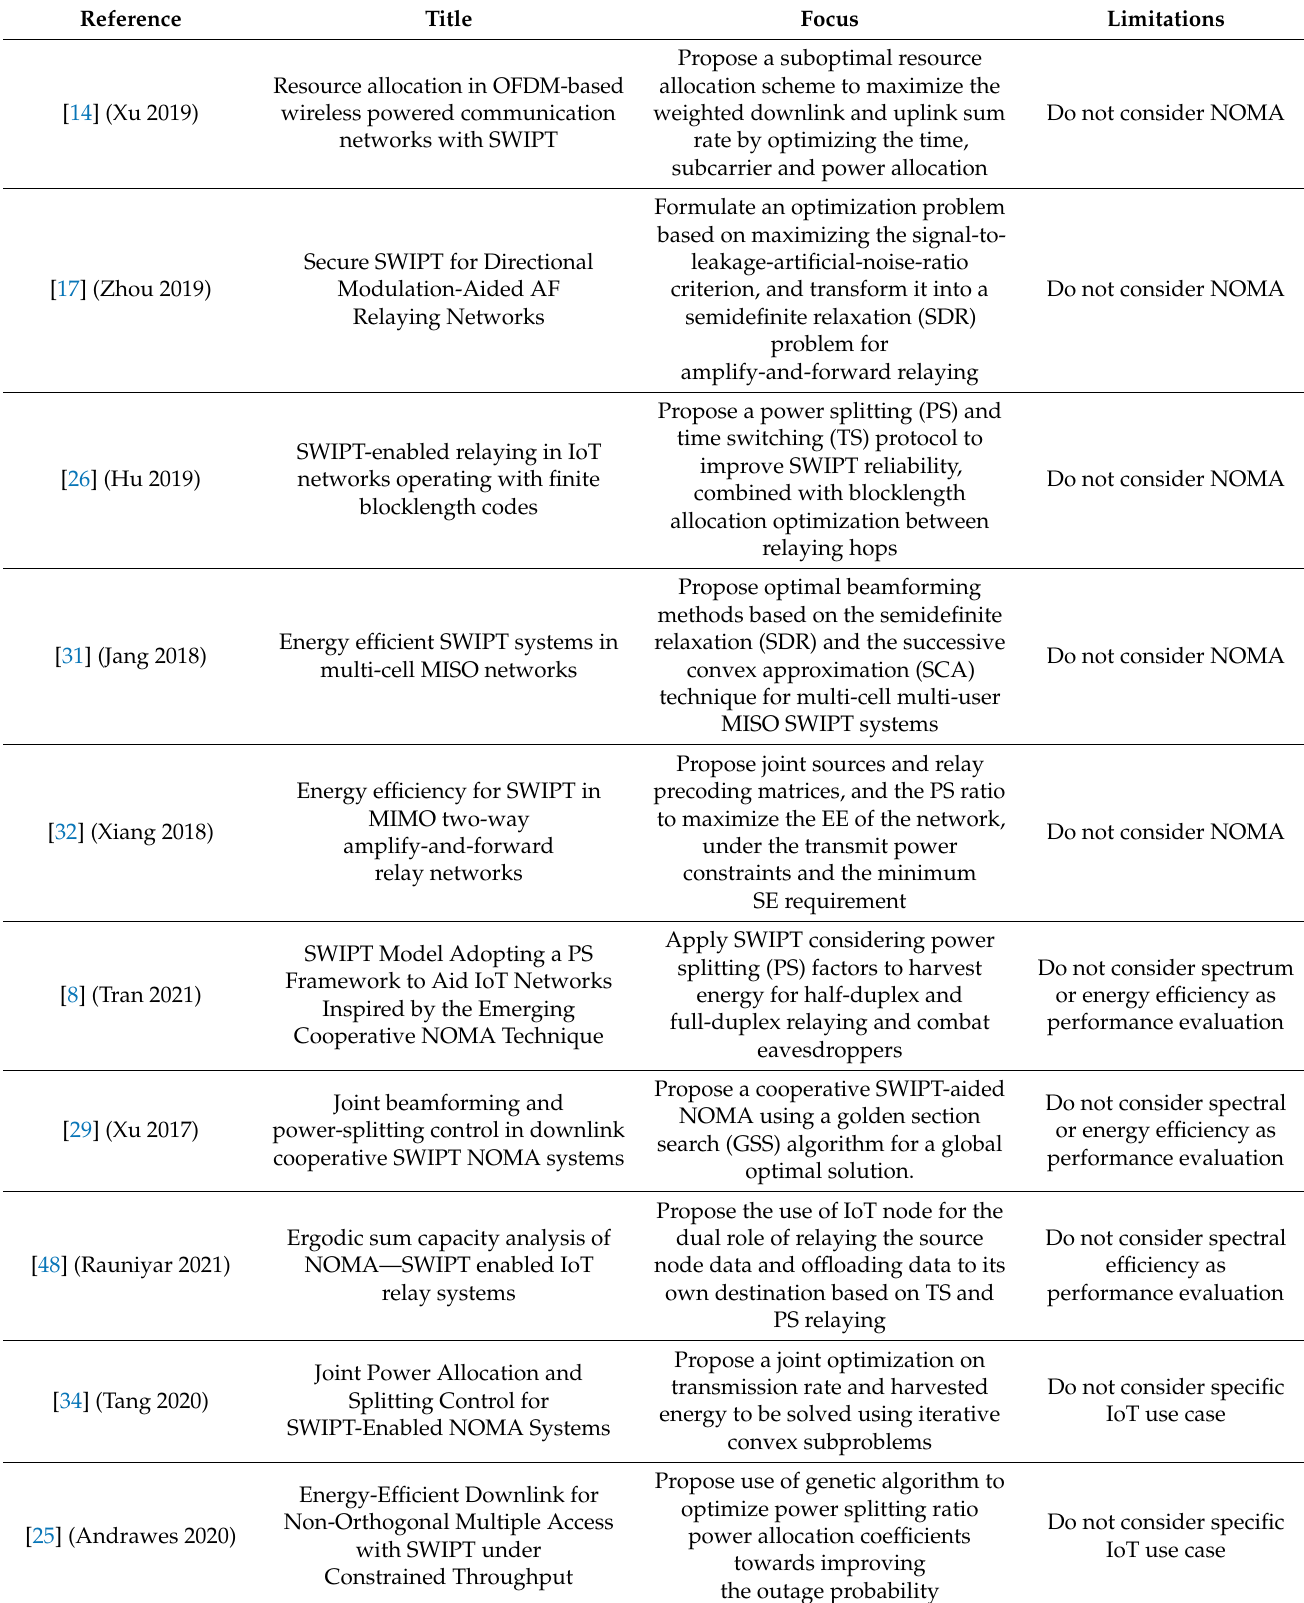
Table 1. Summary of recent works on SWIPT-aided energy